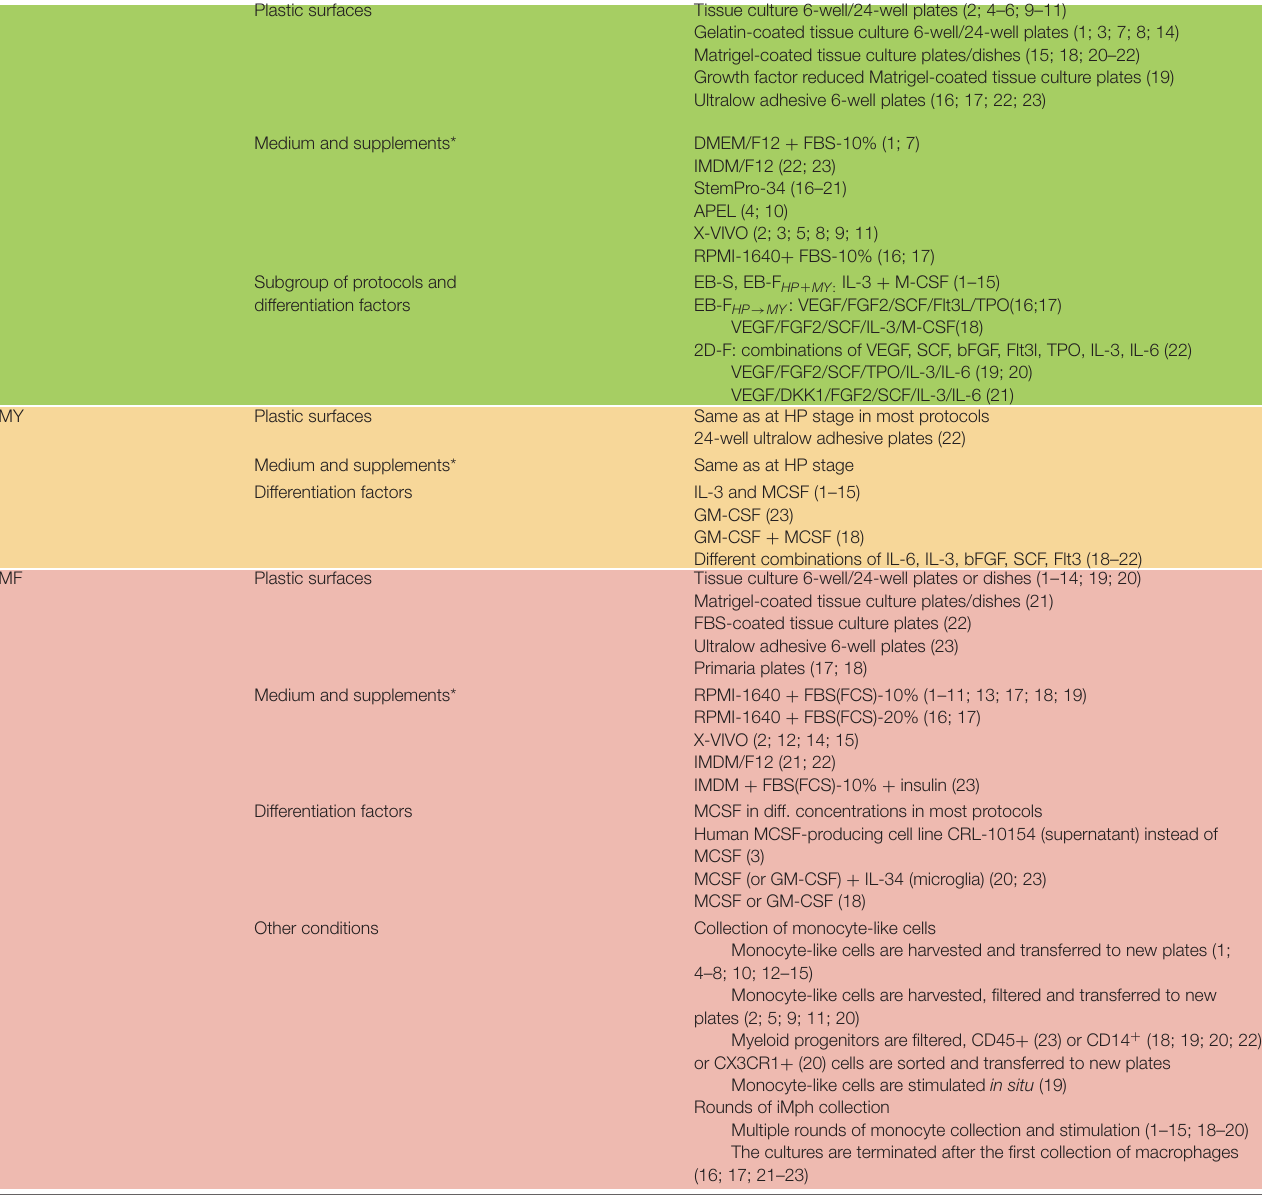
TABLE 2 | Variability of iMph differentiation protocols at HP, MY, and MF